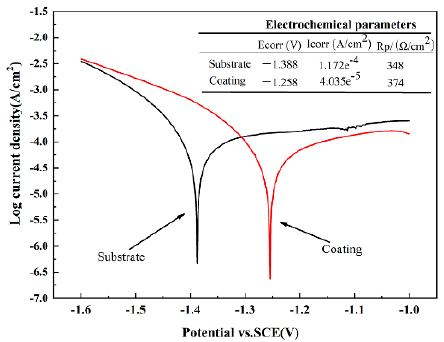
Figure 14. The potentiodynamic polarization curves for the coating and substrate.